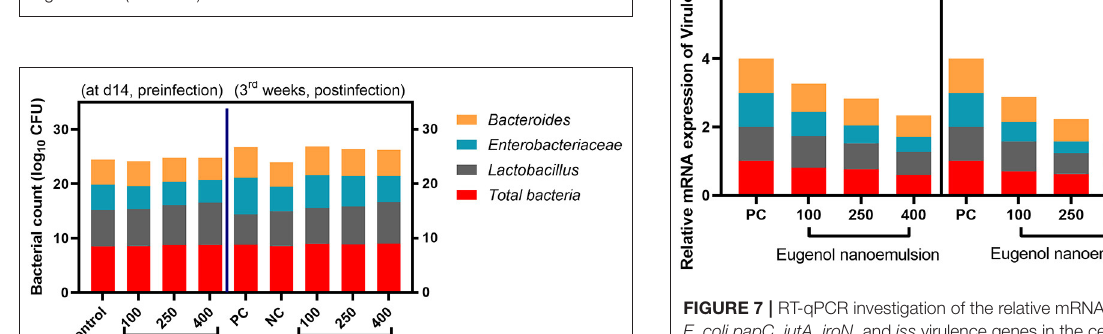
FIGURE 4 | Heat map depicting RT-qPCR analysis of the relative expression levels of mRNAs encoding cytokines; IL-6 (interleukin-6), IL-8, IL-1 β , IL-10, and TNF- α (tumor necrosis factor alpha) in the jejunal segments of broiler chickens fed different levels of eugenol nanoemulsion pre- (at day 14) and post- (at 3rd week) E. coli O78 challenge. Values are means with their SE. The intensity of orange and blue colors denotes the degree of upregulation and downregulation of the investigated genes, respectively. NC (negative control): birds fed basal diet without eugenol nanoemulsion and were not challenged, PC (positive control): birds fed a control diet without eugenol nanoemulsion and were challenged, eugenol nanoemulsion 100, 250, and 400: birds fed basal diet supplemented with 100, 250, and 400 mg/kg diet eugenol nanoemulsion. All groups except NC were challenged with E. coli O78 at 14 days of age. Different letters within the same row indicate a statistical significance ( P < 0.05).